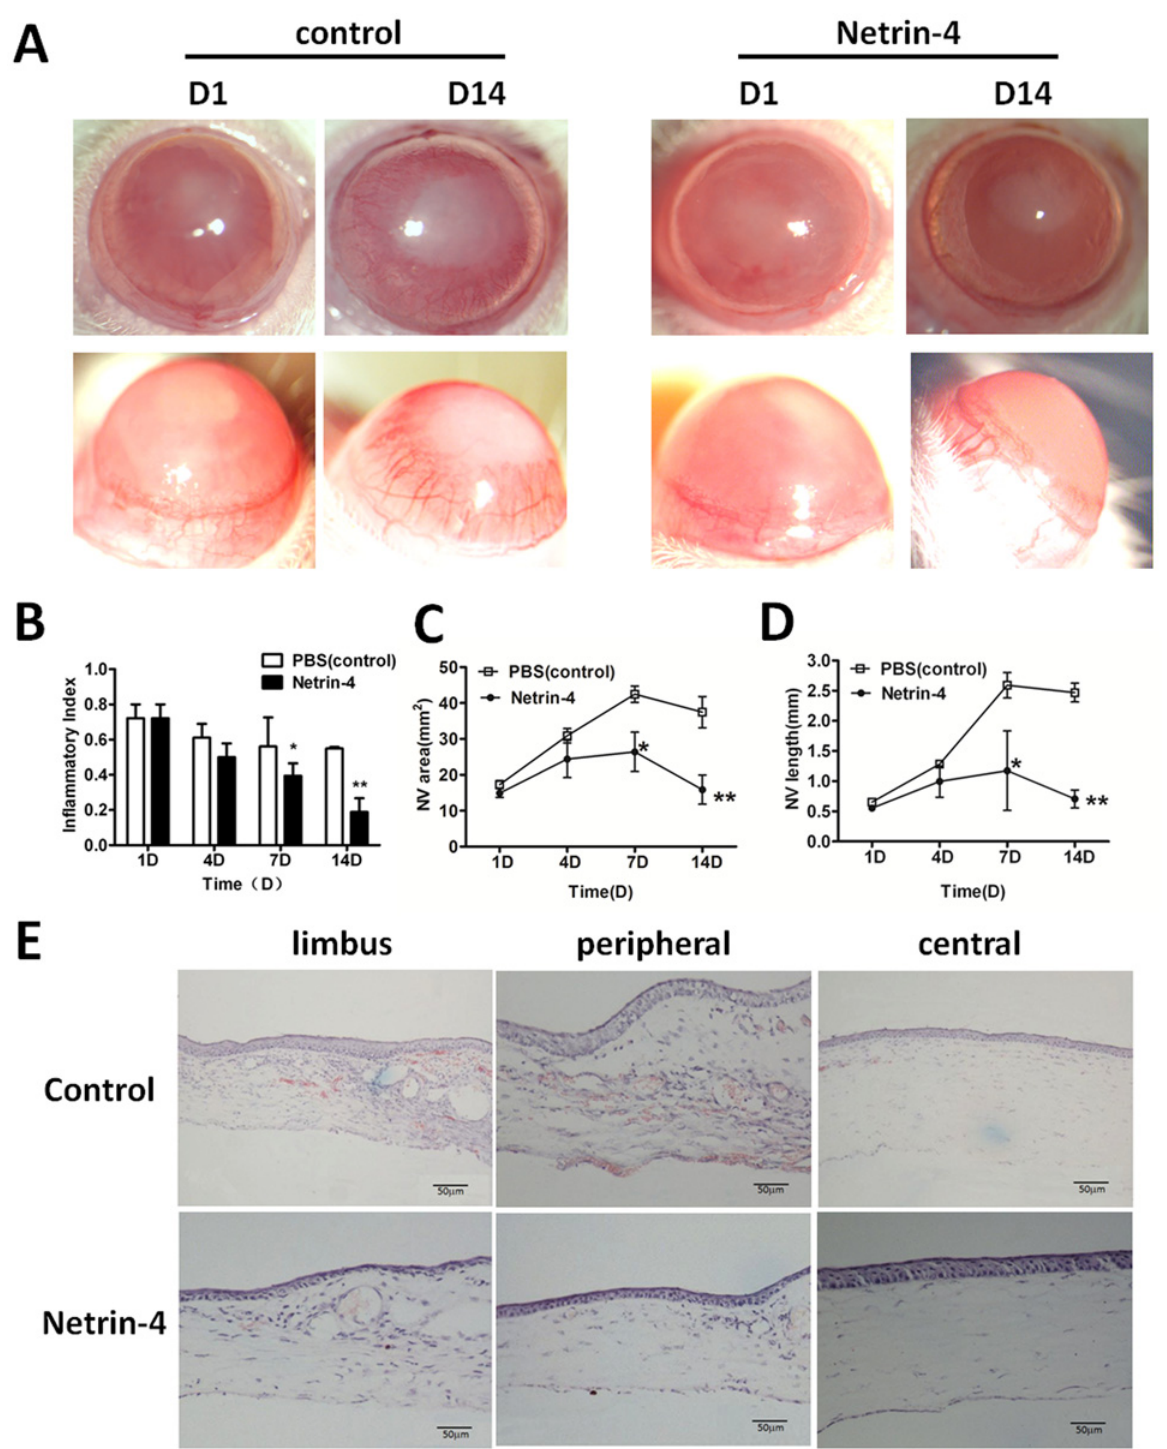
Fig 5. Netrin-4 prevents corneal neovascularization after alkali burns. (A) One day after the alkali burns, the central corneal stroma of the rats appeared opaque and edematous in both groups. On day 14 after the injury, new blood vessels reached the central corneas in the control group, and there was a remarkable decrease in corneal transparency. In contrast, there was only slight new blood vessel formation in the limbal areas in the netrin-4 treatment group, and the corneas remained transparent on day 14. (B) The inflammatory index of the ocular surface declined from day 1 to day 14 in both groups. However, it was significantly lower in eyes treated with netrin-4 on day 7 and day 14 ( * p < 0.05 and ** p < 0.01). (C) New blood vessel formation area (NV